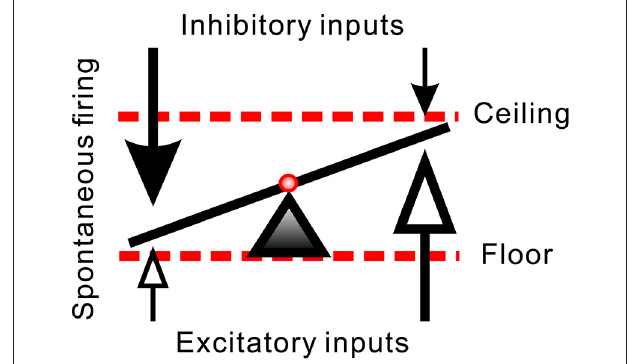
FIGURE 9 | Hypothetical synaptic inputs governing spontaneous firing activities of SPNs. Arrows represent vectors of synaptic inputs. The triad pointing to the slanting line marks the activity level of an SPN. The activity levels result from different extents of inhibitory and excitatory inputs. Effects of a diffusive NO-mediated synaptic modulation on the activity levels are limited by a floor effect of inhibitory inputs (i.e., quiescent SPN cannot be further silenced by excessive inhibition) and by a ceiling effect of excitatory inputs (i.e., active SPN cannot be further activated by excessive excitation). In case that L-NAME enhances synaptic transmissions, the inhibitory floor and excitatory ceiling effects favor a more effective excitatory enhancement in SPNs of low spontaneous activity and more inhibitory reduction in SPNs of high spontaneous activity (i.e., the values of the vectors of low magnitudes in both ends are effectively increased). In case that Arg reduces synaptic transmissions, the same effects favor a removal of strong inhibitory inputs in SPNs of low spontaneous activity and a removal of strong excitatory inputs in SPNs of high spontaneous activity (i.e., the values of the vector of high magnitudes are substantially